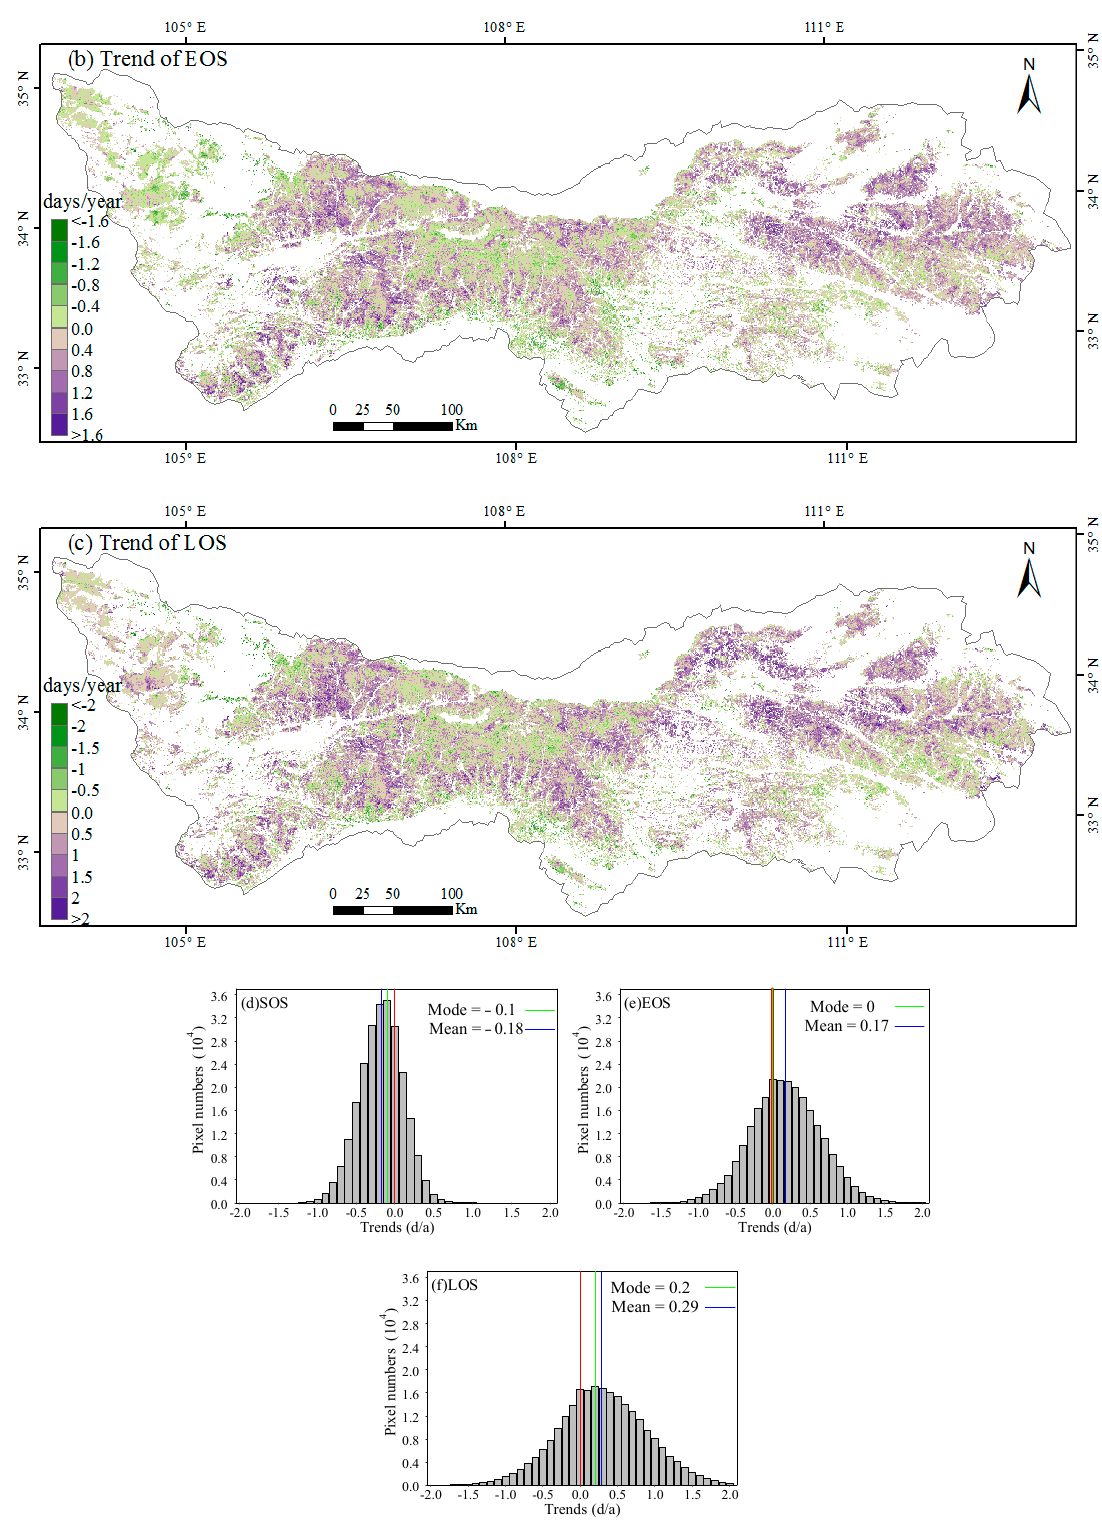
Figure 5. Spatial patterns of the linear trends in SOS ( a ), EOS ( b ), and LOS ( c ) and statistics of the entire linear trends in SOS ( d ), EOS ( e ), and LOS ( f ), from 2001 to 2017 in the QMs. The red, green, and blue lines in (d–f) are the 0, mode and mean values of the trends of SOS, EOS, and LOS, respectively.